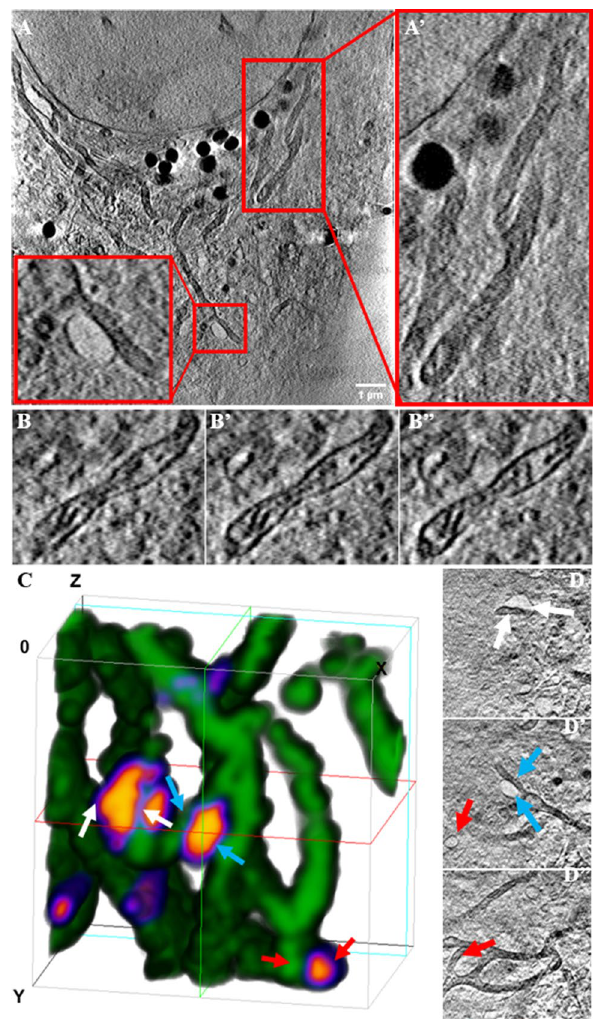
Figure 2. Soft X-ray tomography (SXT) reveals the ultrastructure of mitochondria and shows contacts to endosomes. NPC2−/− fibroblasts were treated with 200 nM NPC2 for 48 h, labeled with TopFluor-cholesterol, chased for 2 h and fixed with PFA. The cells were kept in PBS until plunge freezing in liquid ethane followed by imaging of tomograms at the X-ray microscope, spatial registration and 3D reconstruction of tomograms (see Materials and Methods for details). A – A ’, right red box and zoom highlight a branched mitochondrion, while lower left box and zoom point to a contact area between a mitochondrion and an endosome-like vesicle. B , sections though another mitochondrion reveals its ultrastructure with clearly discernable cristae. C – D ’’, 3D rendering of the reconstructed tomogram shown in D. Different colored arrows in D , D ’, D ’’ point to endosome- like in close contact with mitochondria, the corresponding color arrows point to same structures in the rendering in C. Bar, 1